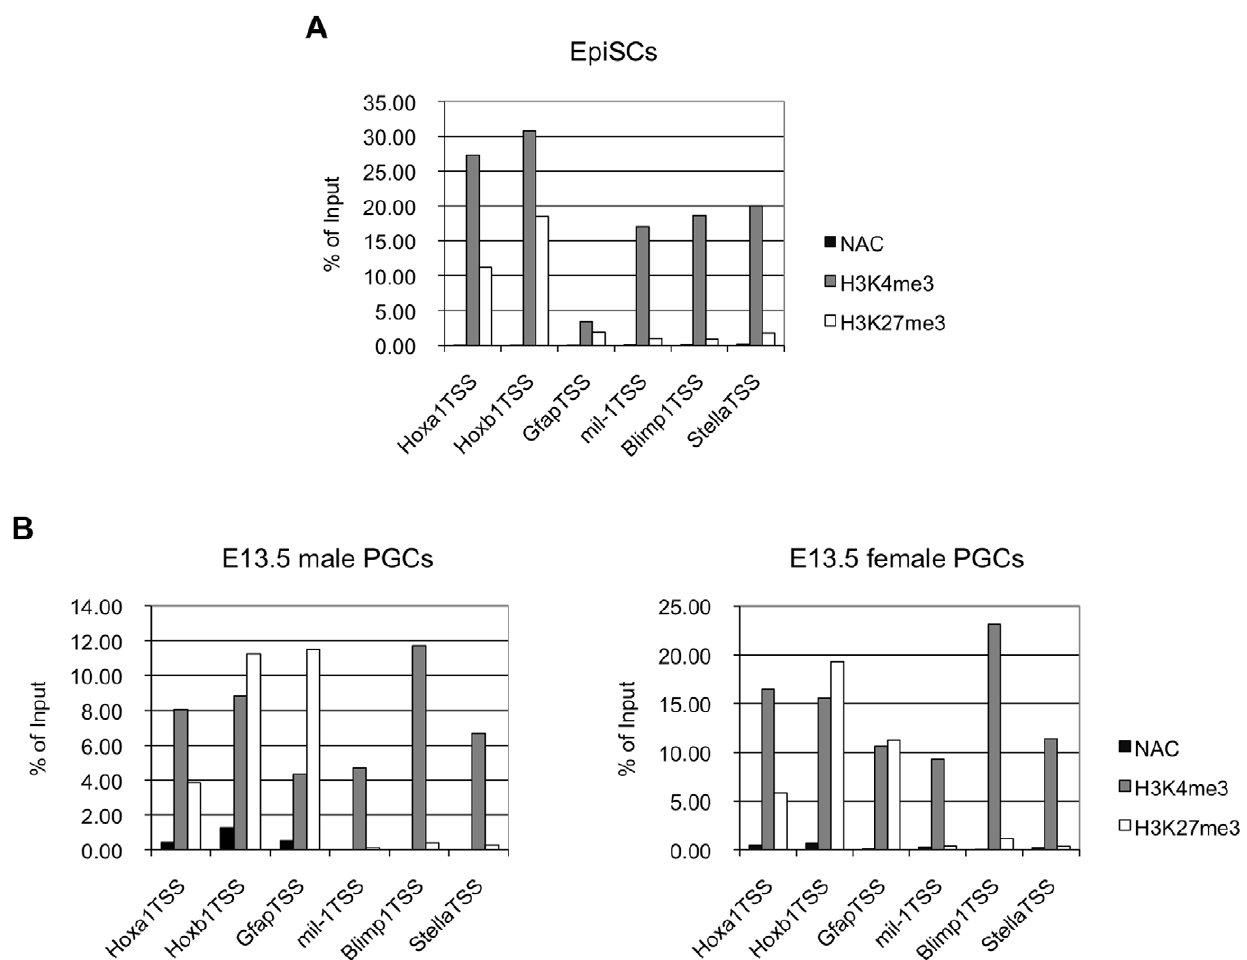
Figure 8. Bivalent histone modification on the somatic genes in PGCs. (A, B) ChIP analysis with the H3K4me3 or H3K27me3 antibodies for the promoter regions of somatic genes ( Hoxa1 , Hoxb1 , and Gfap ) and of the PGC-specific genes ( mil-1 , Blimp1 , and Stella ) was performed on EpiSCs (A), and male and female PGCs at E13.5 (B), showing the bivalent histone modification. Histogram represents ratios of the immuno-precipitated chromatin to the input chromatin, which was quantified by quantitative PCR analysis. Also shown are results using beads only as a no antibody control (NAC). Shown is a representative data from two independent experiments.